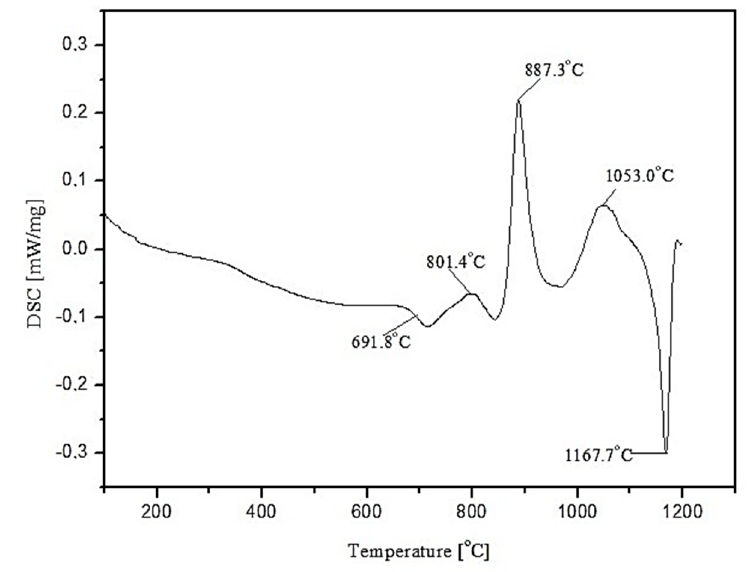
Figure 6. DSC curve of amphibolite glass with 20 wt.% dolomite addition (Set 3*).